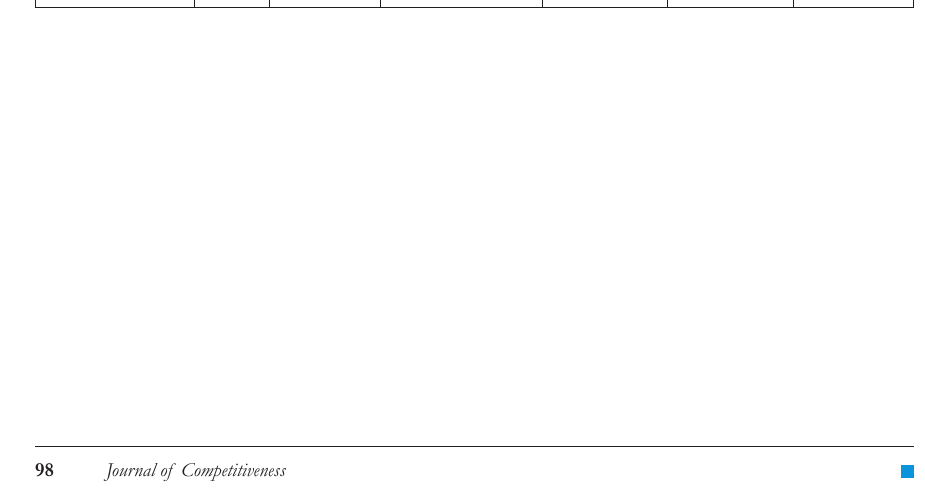
Coeff. Std. Deviation (%)